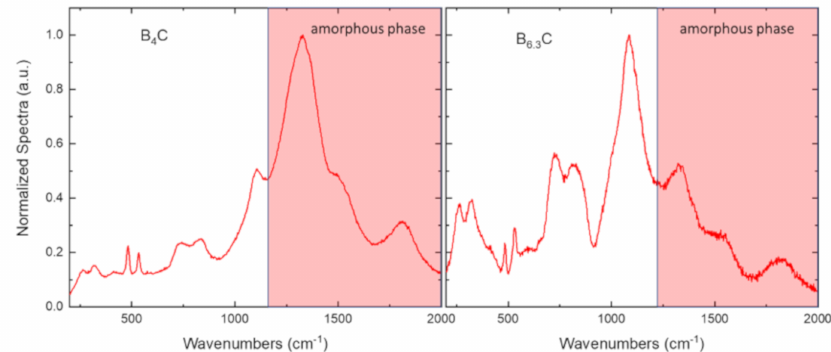
Figure 3. Comparison of amorphized Raman spectra of B 4 C (left) and B 6.3 C (right). Amorphous peaks (greater than 1200 cm − 1 ) are highlighted in red.